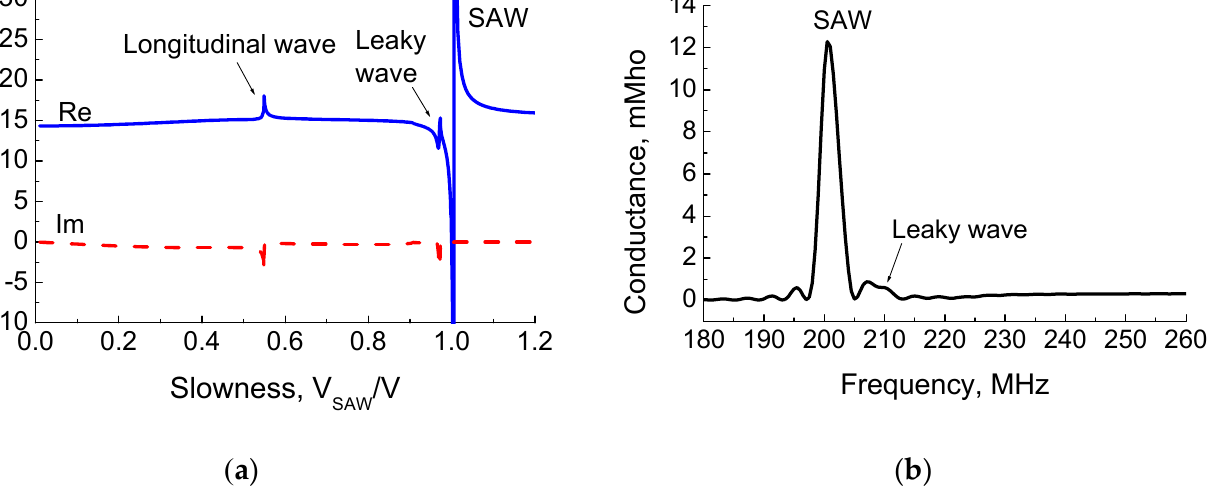
Figure 5. ( a ) Effective permittivity ε eff / ε 0 versus dimensionless slowness V SAW /V and ( b ) surface wave IDT conductance response versus frequency for the uniform IDT having 100 Al electrodes with period λ = 20 μ m and electrode thickness h/ λ = 1% on the Z-cut and the wave propagation direction along the crystal X + 70°-axis.